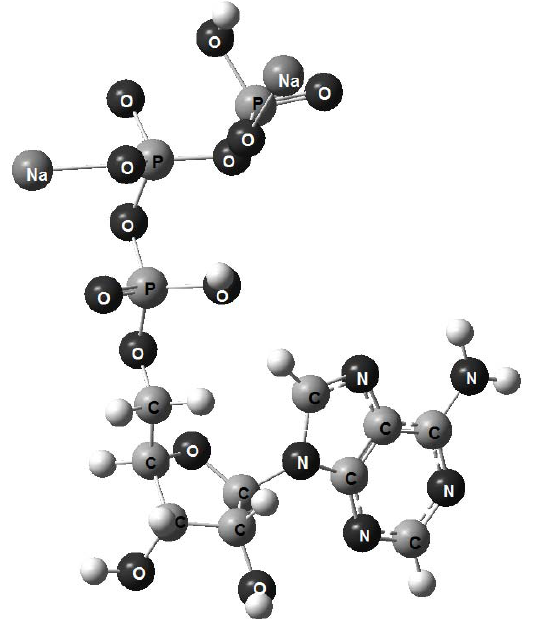
Figure 3. A stereoview of the model representing ATP sodium